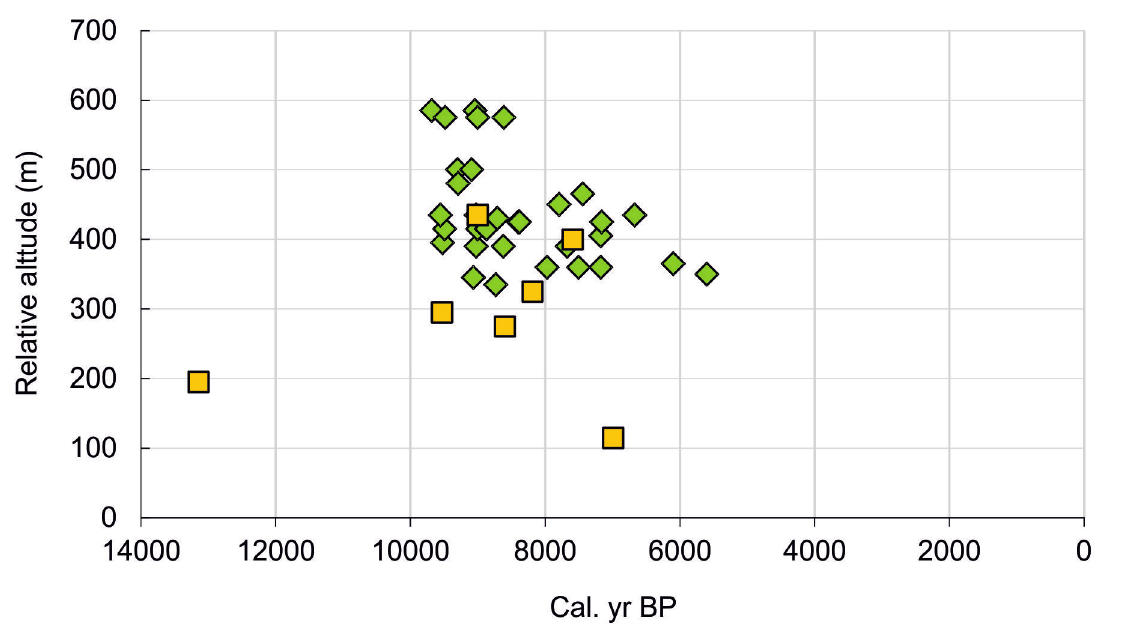
Figure 26: Radiocarbon dates of birch (green) and pine (yellow) megafossils, relative to the present day position of the birch treeline (zero). Helags/Sylarna